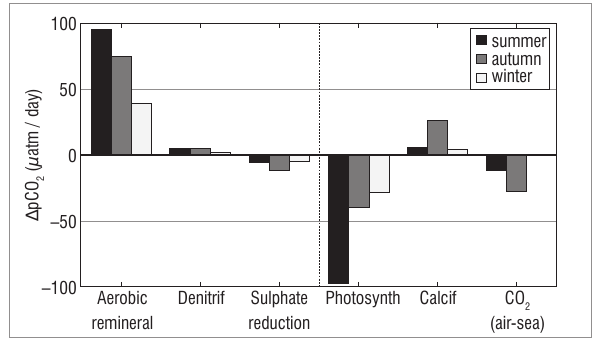
by primary production, aerobic Figure 4: Average rates of change of pCO 2 remineralisation, denitrification, calcification and air–sea CO flux 2 for the three seasons. Photosynthesis and denitrification were consistently the largest contributors to net flux. A summary of the method used to find the contribution of the listed processes to dissolved inorganic